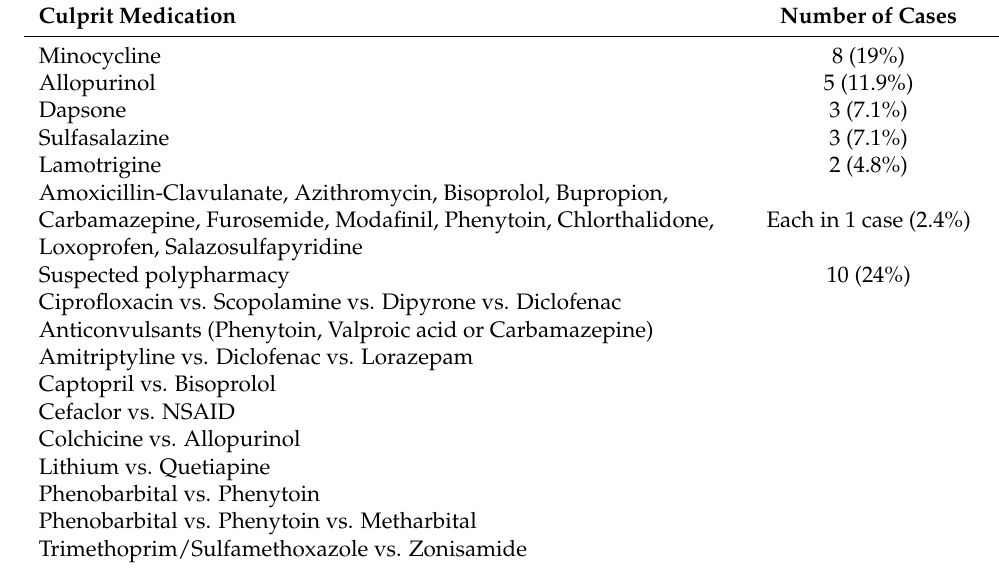
Table 3. List of the culprit medication in patients with DRESS syndrome who had cardiac